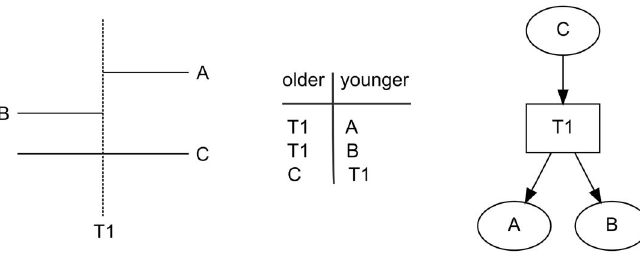
Figure 3. Relative chronological relationships of agricultural walls and trails. Left , map showing trail T1 and agricultural walls A , B , and C ; middle , table of chronological relationships shown on the map; right , picture of a directed graph of the chronological relations where ovals represent agricultural walls, the rectangle represents a trail, and arcs point from an older feature to a younger one.